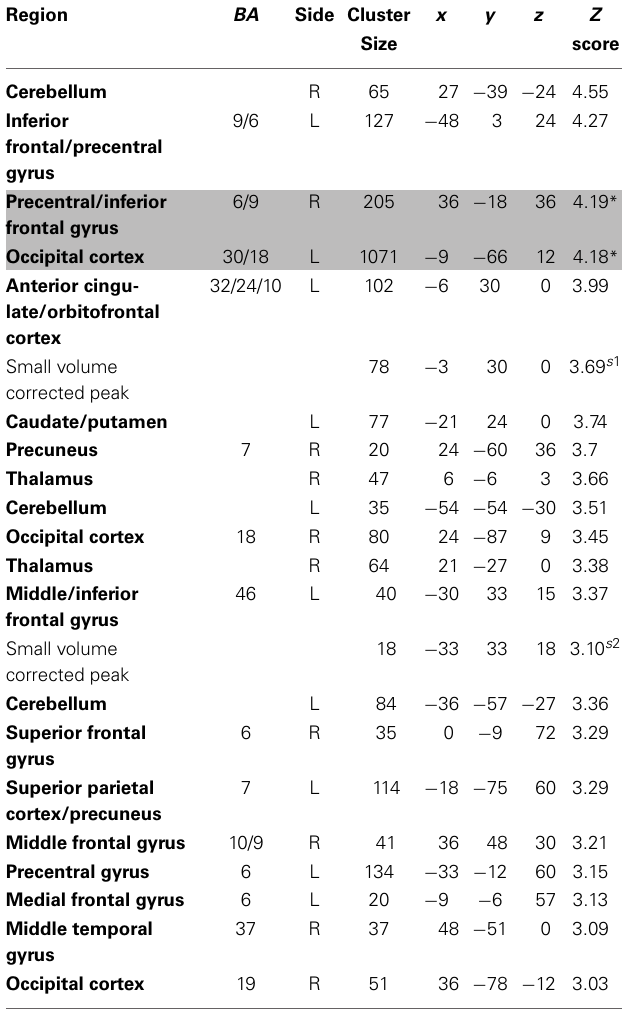
Table 6 | Regions more active when accepting delayed rewards controlling for discounted stimulus value in